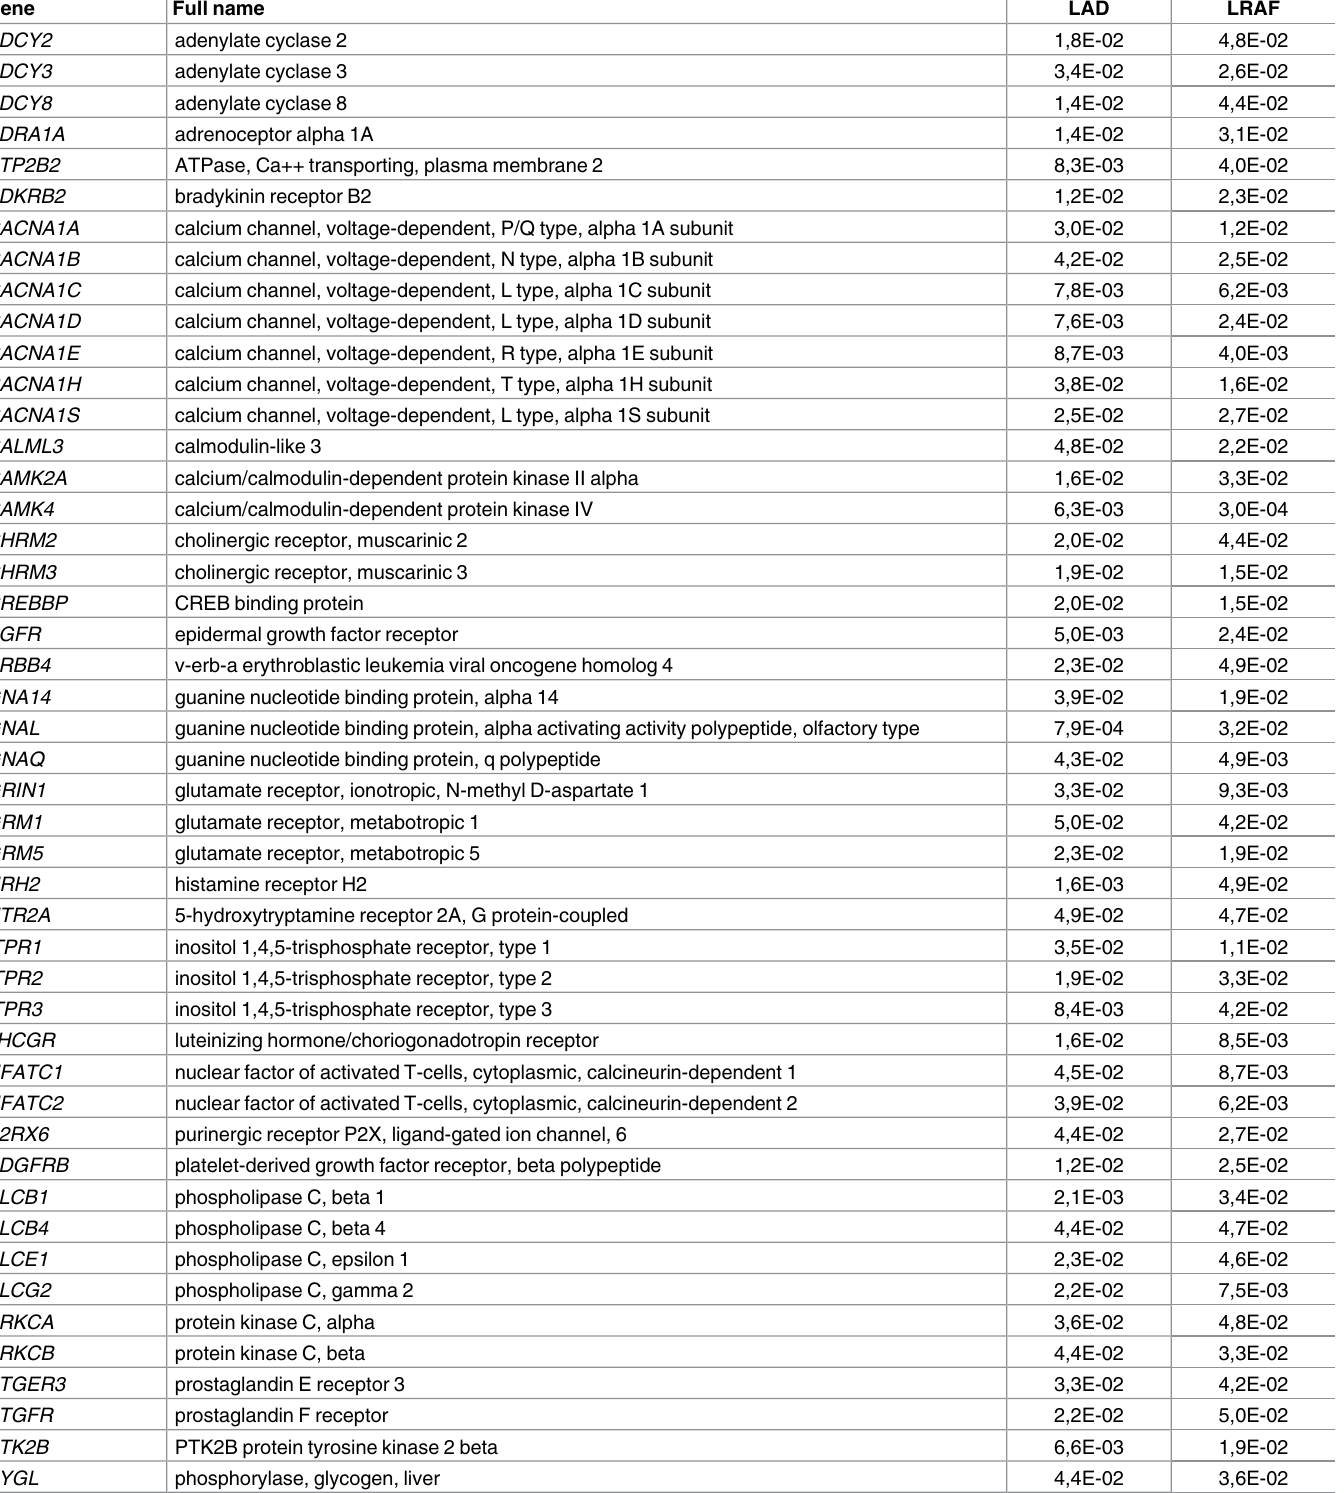
Table 3. Genes of the calcium signaling pathway associated with LAD and LRAF (in alphabetical order).